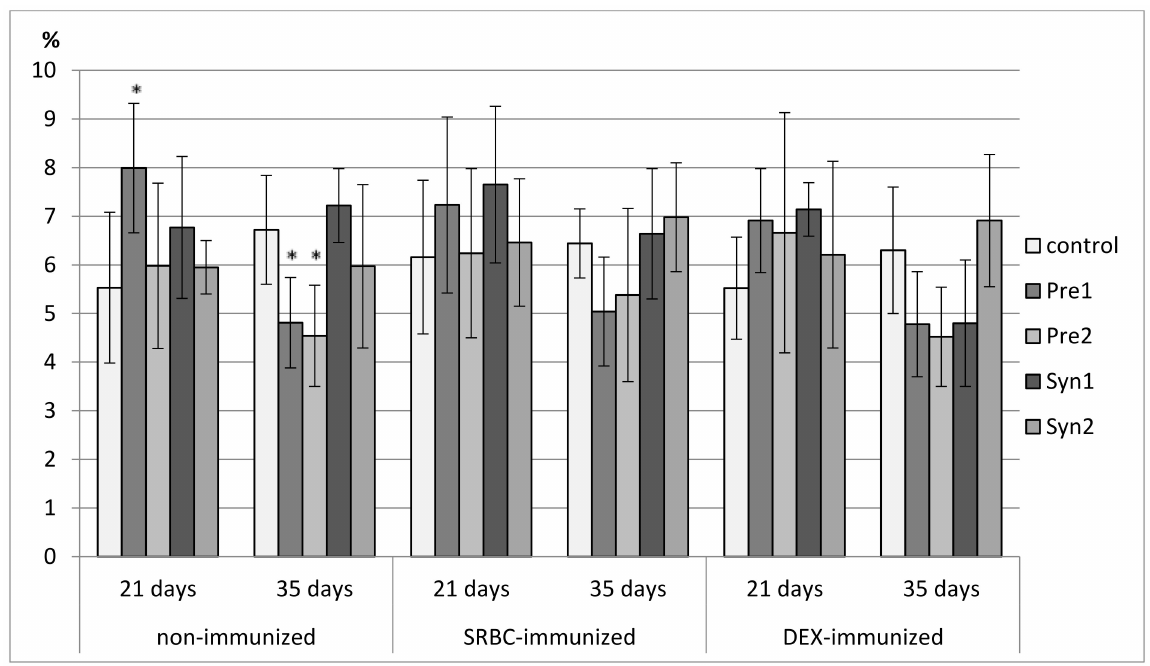
Figure 5. The percentage of CD8 + cells in the thymus of chicken broilers after in ovo injection of the investigated prebiotics or synbiotics. The data are expressed as the mean ± SD. Data with a symbol (*) denote a significant difference with respect to the control group ( p <